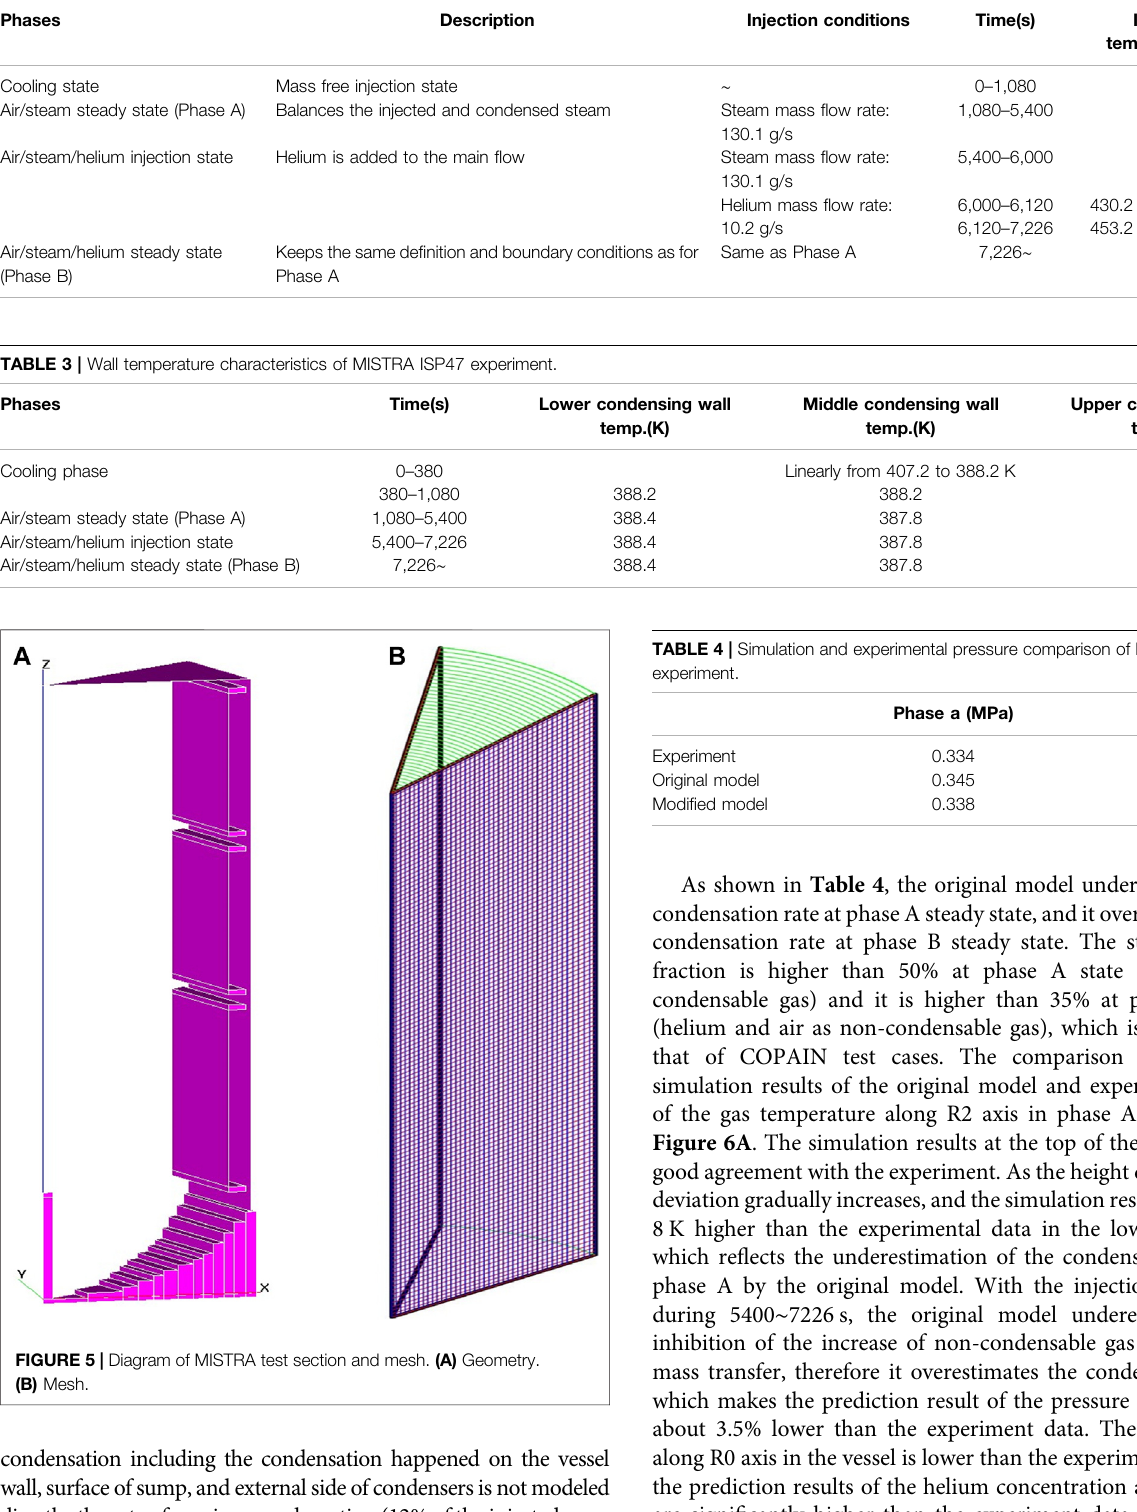
TABLE 2 | Injection characteristics of MISTRA ISP47 experiment.